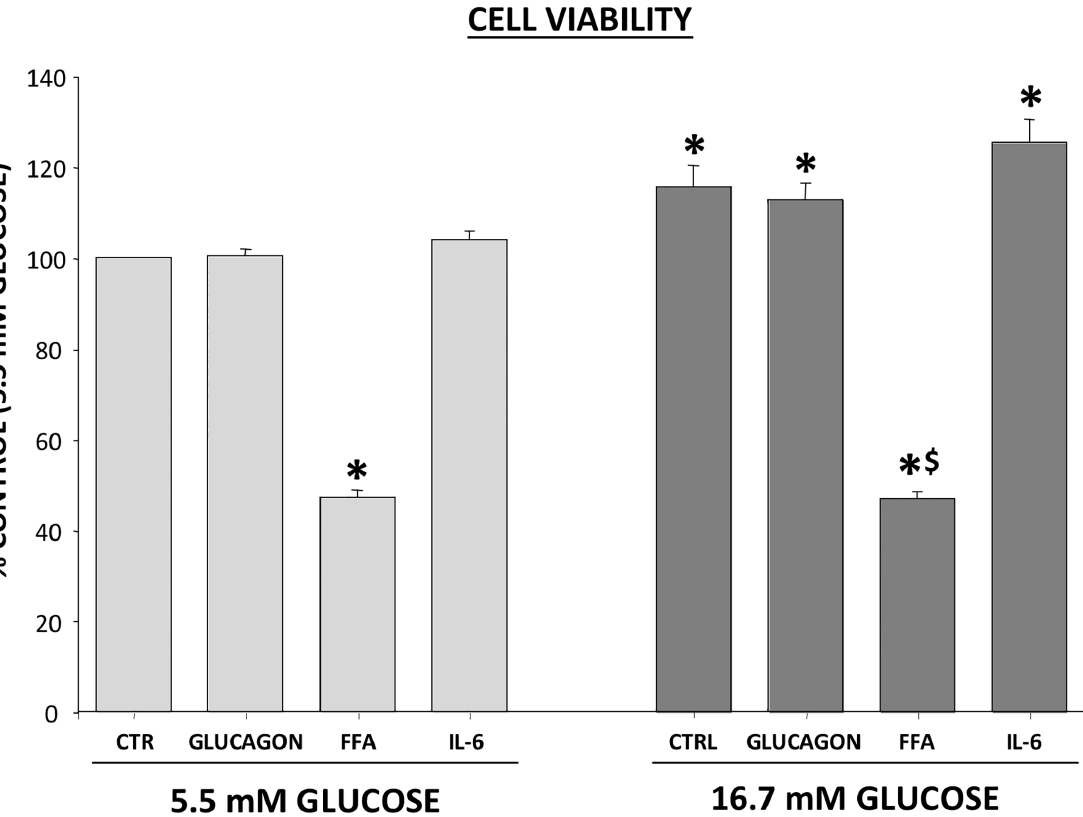
Fig 1. Effect of metabolic/hormonal pertubation on cell viability. Cells were incubatedfor 16 h in the presenceof 5.5mM or 16.7mM, in the additionalpresenceof glucagon, FFA and IL-6 and cell viability was determined by MTT method. Results are % of control (cells incubatedin 5.5mM glucose)and expressedas MEAN ± SEM, n = 4. * p < 0.05comparedto 5.5mM glucosecontrol; $p < 0.05compareto 16.7mM glucose control.